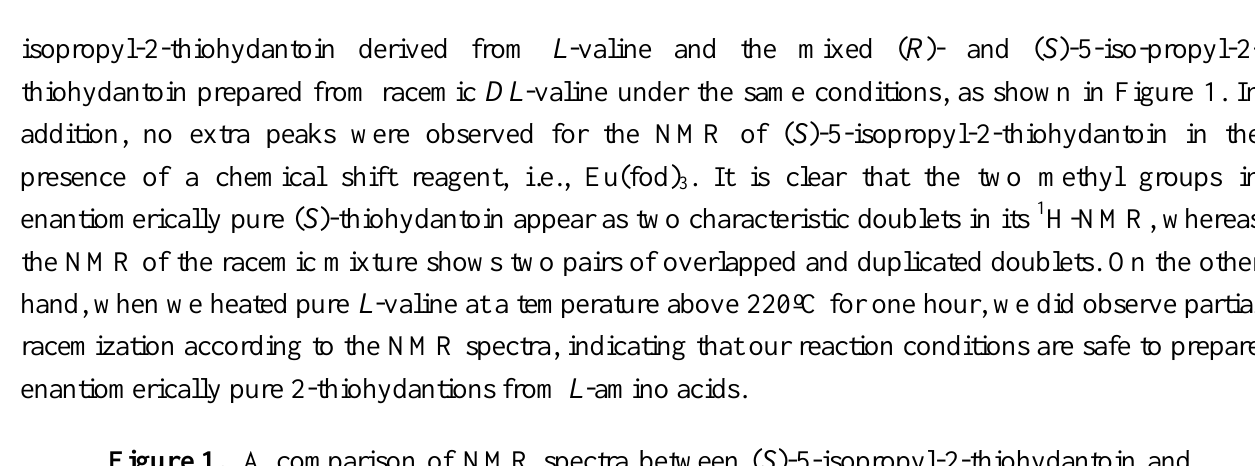
Figure 1. A comparison of NMR spectra between ( S )-5-isopropyl-2-thiohydantoin and the mixed